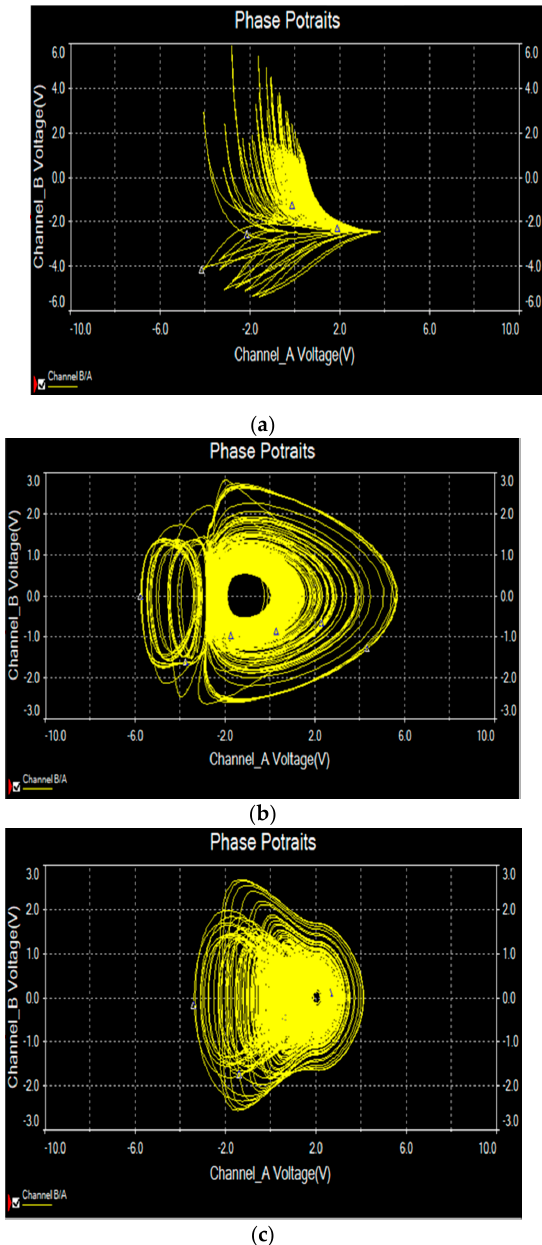
Figure 7. Phase portraits of the new chaotic system in Multisim ( a ) X-Y plane, ( b ) Y-Z plane and ( c ) X - Z plane.